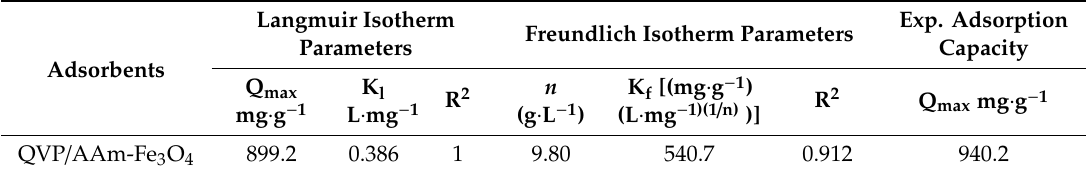
Table 1. Adsorption isotherm parameters of CR dye using QVP / AAm-Fe 3 O 4 composites at temperature 298 K. Langmuir Isotherm Freundlich Isotherm Parameters Adsorbents